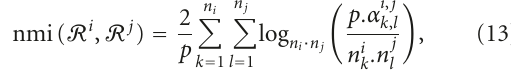
Table 1. As expected, the collaborative solution has produced the best results, especially for the fields detection.